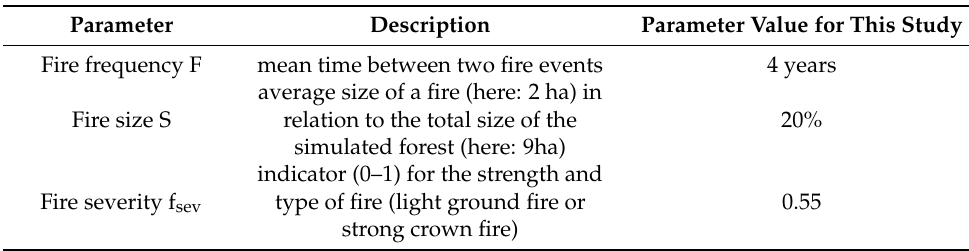
Table 1. Parameter of the fire model ForFire and parameter values for the study region for the scenario where repeated fire events are simulated. For the scenario with only one fire event, the parameters are S = 60% and f sev = 0.67).